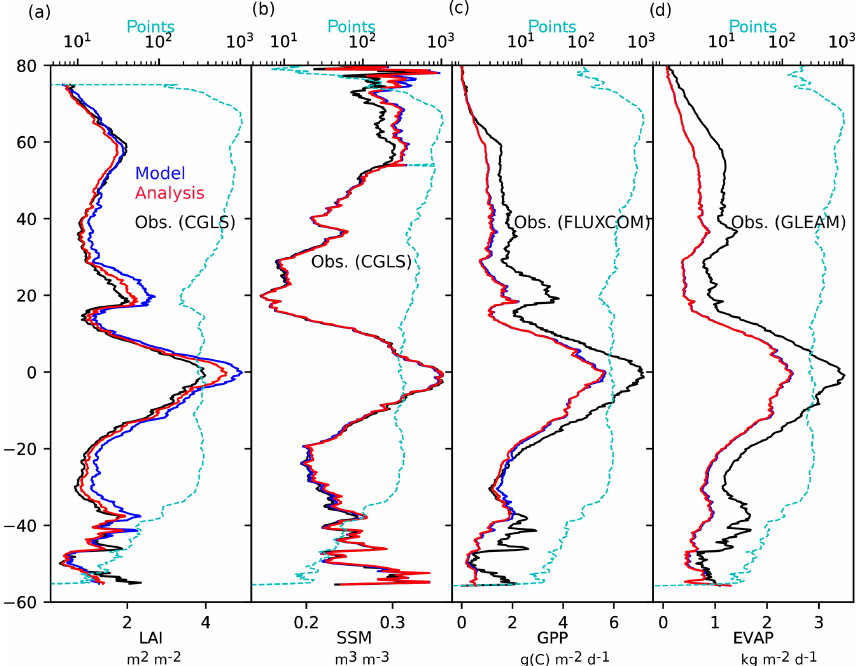
Figure 4. Latitudinal plots of (a) leaf area index (LAI), (b) surface soil moisture (SSM), (c) gross primary production (GPP) and (d) evapo- transpiration (EVAP) for LDAS_ERA5 before assimilation (model, blue solid line) and after assimilation (analysis, red solid line) as well as observations (black solid line). Cyan dashed line represents the number of points considered per latitudinal stripe of 0.25 ◦